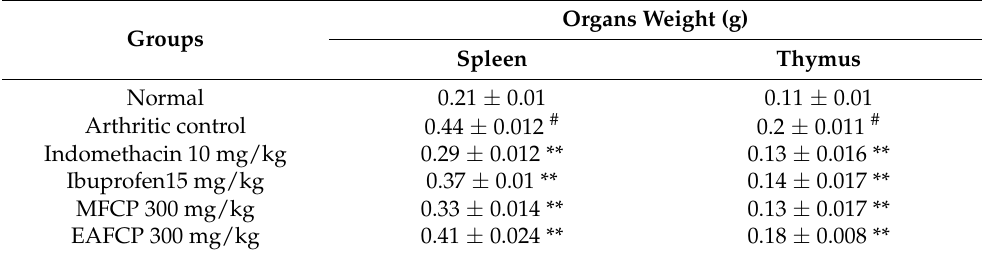
Table 3. Measurement of spleen and thymus weights in FCA-induced arthritis.